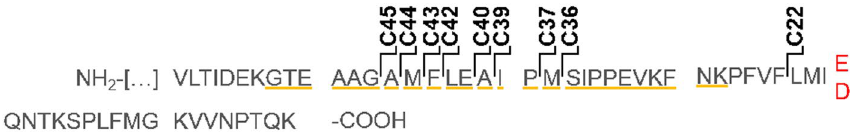
Figure 4. Cleavage sites of selected CAAPs within the C-terminal amino acid sequence of A1AT. CAAPs are named after their respective amino acid lengths after cleavage. Yellow: 25 residue reactive centre loop of A1AT (UniProtKB). Red: single nucleotide polymorphism rs1303 53 in the CAAP sequence (E > D 376